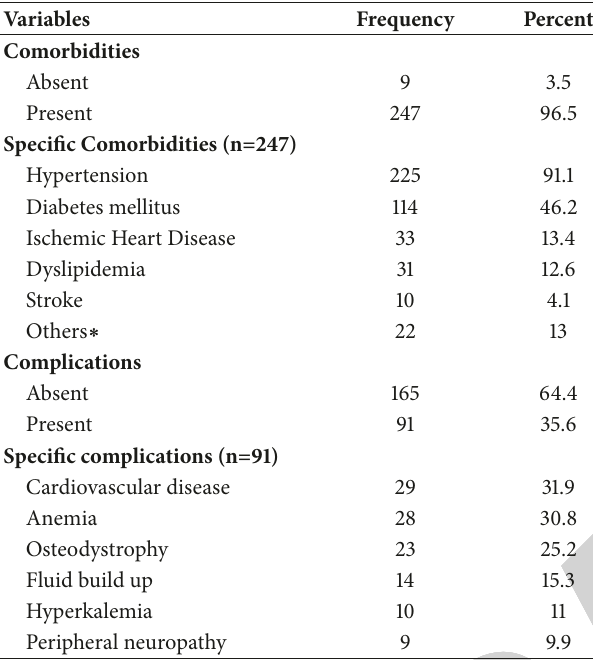
Table 3: Presence of comorbidities and complications among chronic kidney disease patients attending the renal clinic of Tikur Anbessa Specialized Hospital.